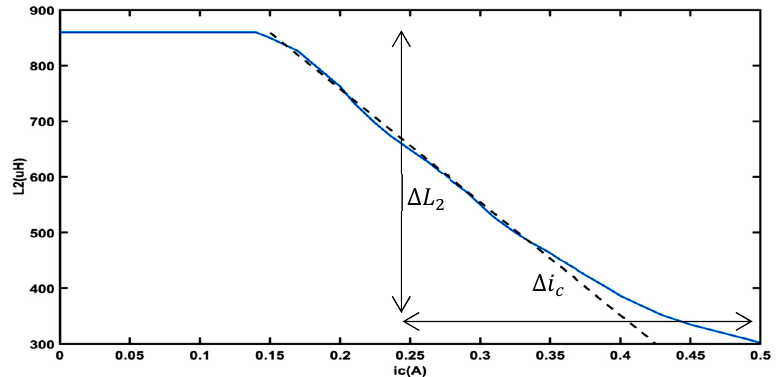
Figure 9. Characteristic inductance curve.